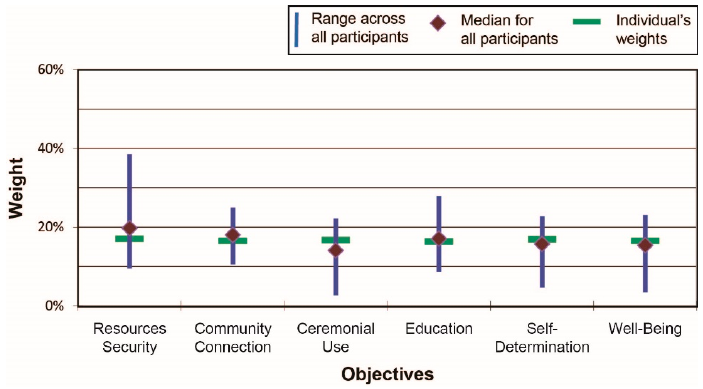
Figure 3. Scenario 1 (beach clean-up) results (At the time of the workshops, the “Resilience” indicator was called “Well-Being”.).